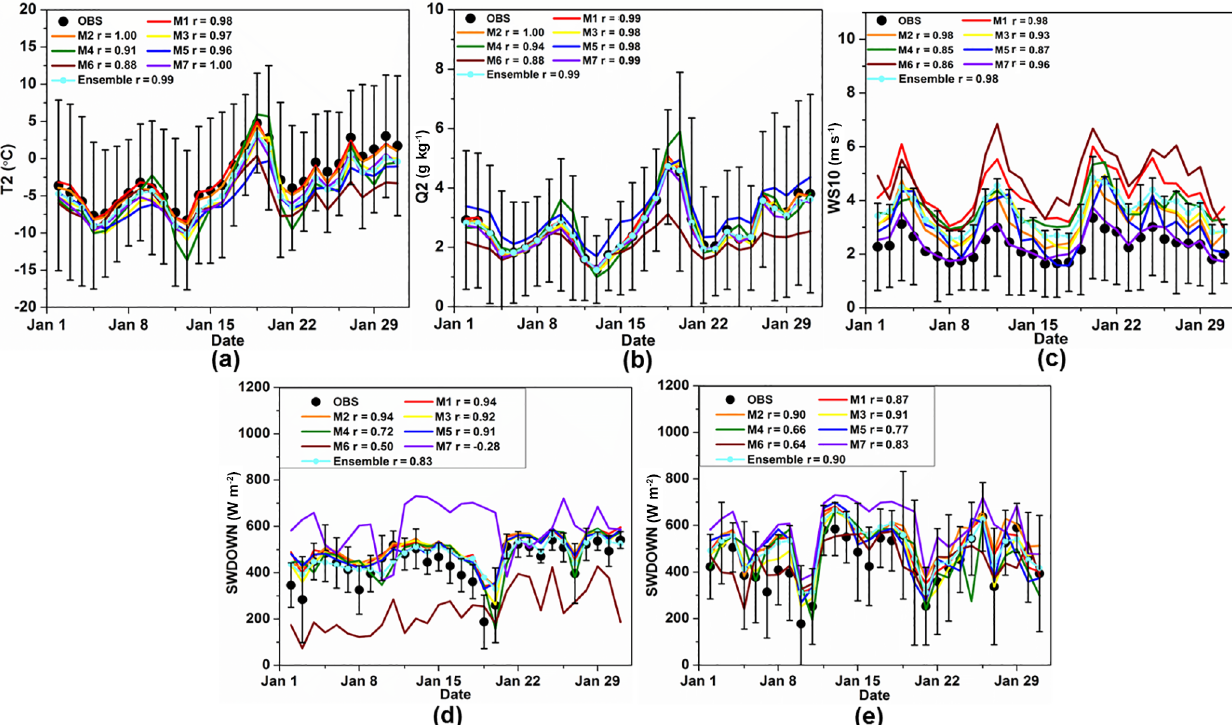
Figure 4. Comparisons between simulated and observed near-surface temperature (a) , water vapor mixing ratio (b) and wind speeds (c) (T2, Q2 and WS10) and downward shortwave radiation in northern China (d) and southern China (e) (spatial daily values are averaged over measurements shown in S4 and S5; the error bars show the SD of values over the measurement sites).